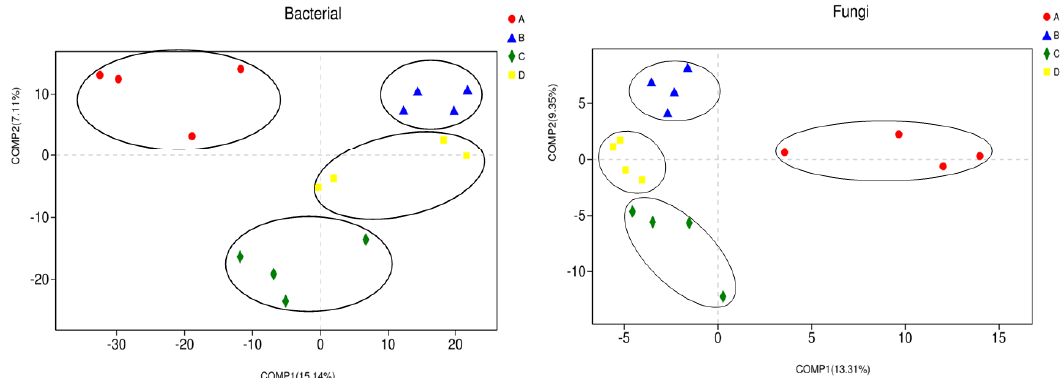
Figure 3. Structural similarity analysis of soil microbial communities among different management treatments by partial least squares discriminant (PLS-DA). A indicates close-to-nature forest management (CNFM), B indicates structure-based forest management (SBFM), C indicates unmanaged control (CK), and D indicates secondary forest comprehensive silviculture (SFCS).